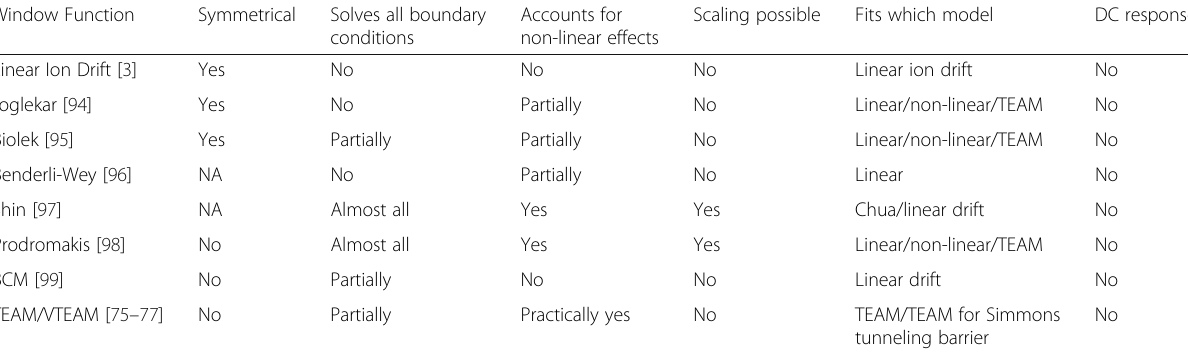
Table 2 Comparison of the window function implementations Window Function